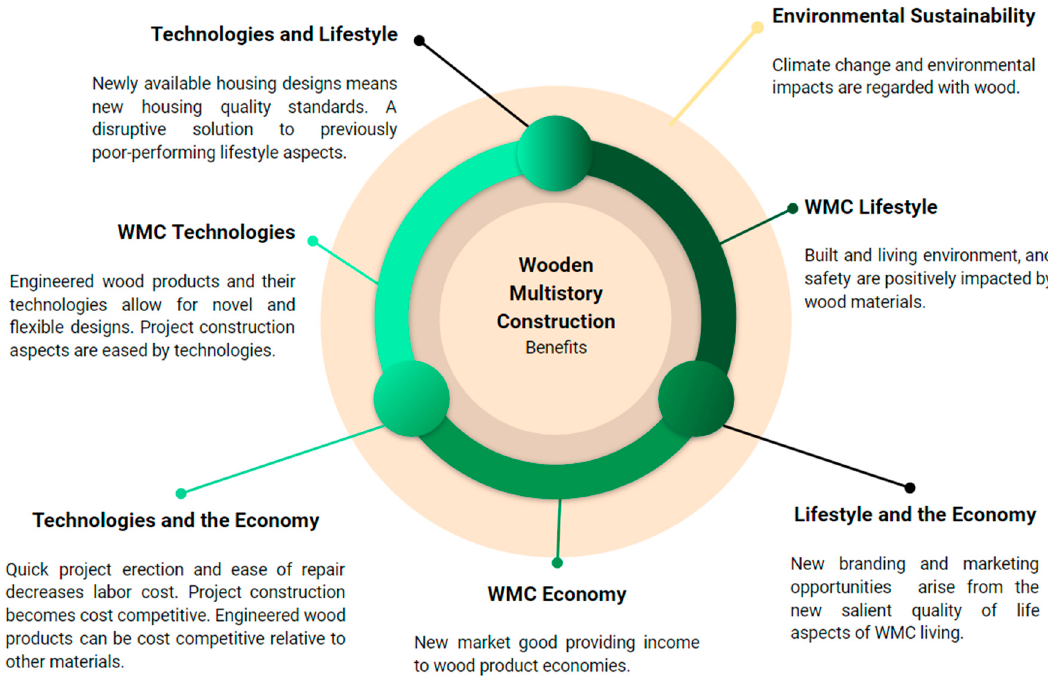
Figure 1. Links between the three major WMC benefit groups (technologies, lifestyle, and economy) are depicted and explained. Please note here that environmental sustainability is an overarching social benefit as opposed to an interconnected theme.